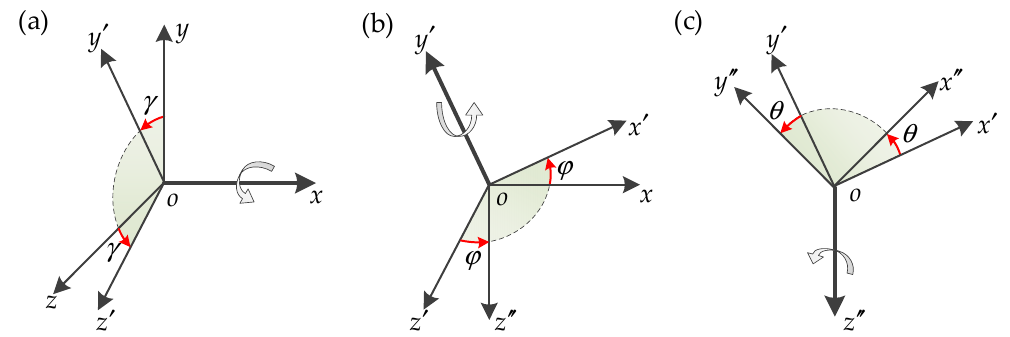
Figure 4. ( a ) Rotation of the inertial frame oxyz around the ox -axis by angle γ ; ( b ) Rotation of the instantaneous system around the oy (cid:48) -axis by angle ϕ ; ( c ) Rotation of the instantaneous system around instantaneous system around the oy’ -axis by angle ϕ ; ( c ) Rotation of the instantaneous system the oz (cid:48)(cid:48) -axis by angle θ around the oz’’ -axis by angle θ .